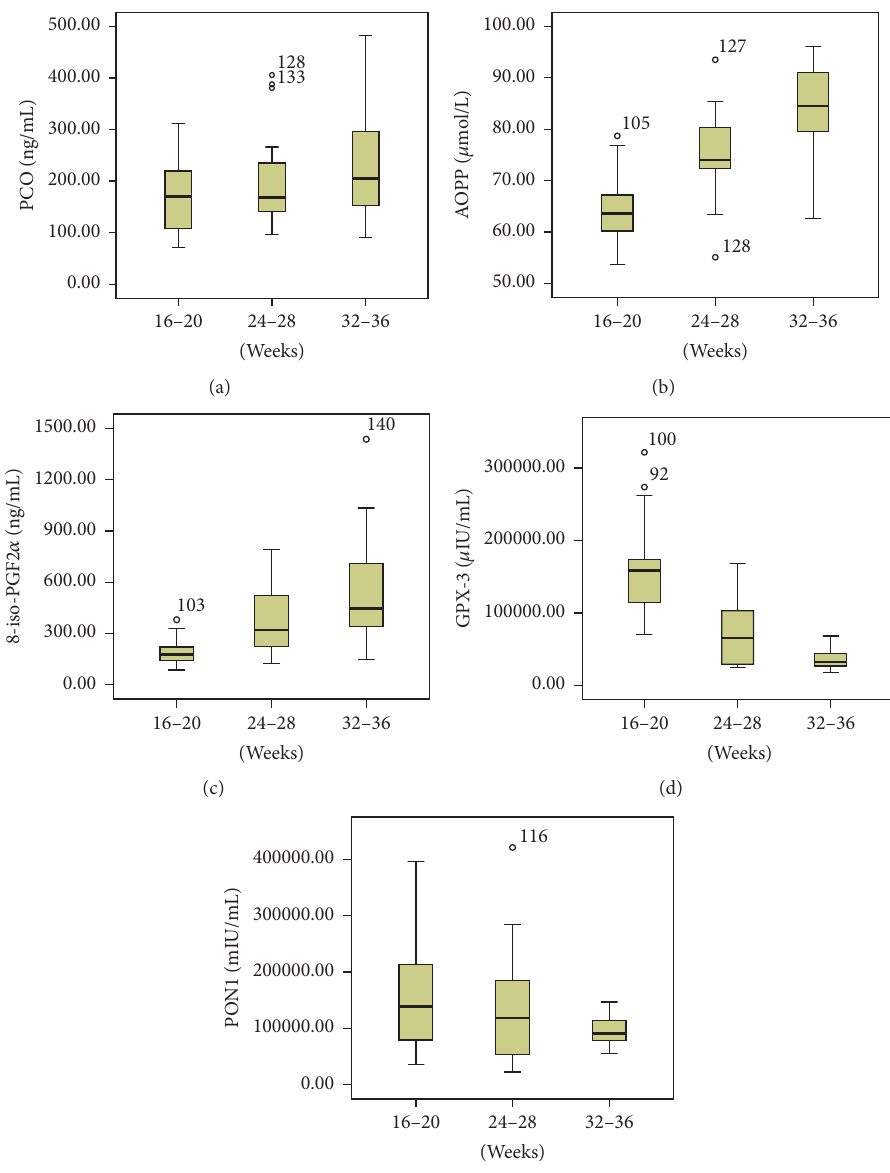
Figure 1: The level of PCO (a), AOPP (b), 8-iso-PGF2 𝛼 (c), GPX-3 (d), and PON1 (e) at 16–20 weeks, at 24–28 weeks, and at 32–36 weeks in